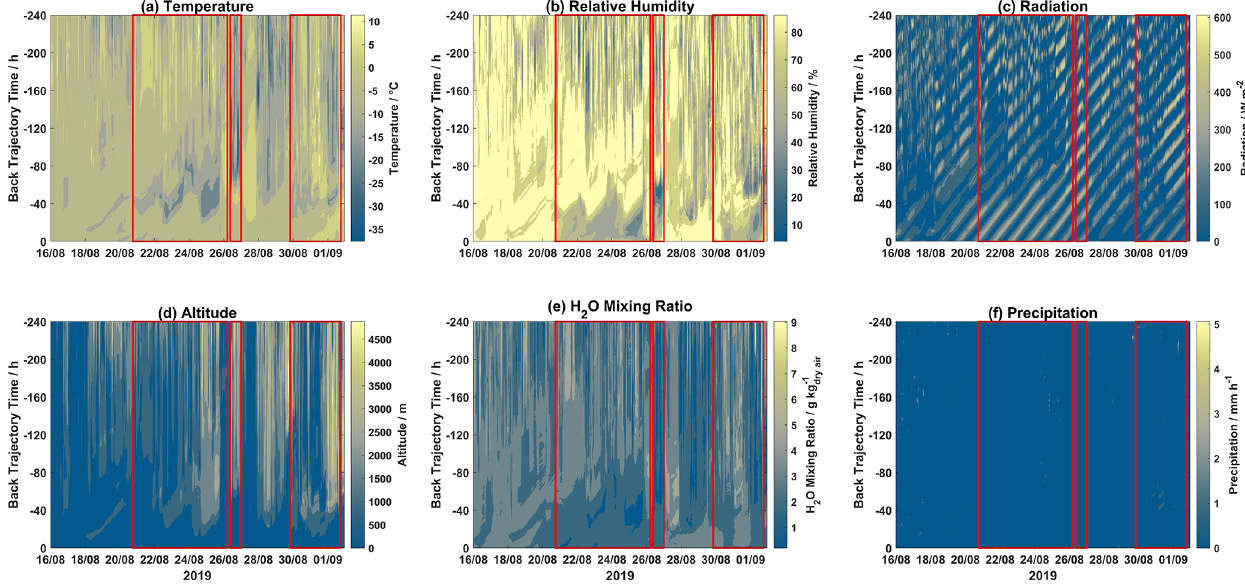
Figure 3. Contour plots of trajectory-derived meteorological parameters, i.e., (a) temperature, (b) relative humidity, (c) solar radiation, (d) altitude, (e) H 2 O mixing ratio, and (f) precipitation, along each trajectory for the 2019 campaign. Event periods are outlined in red. The x axis displays arrival time at Villum, the y axis displays hours backward in time for each trajectory, and the color bar represents the meteorological parameter.